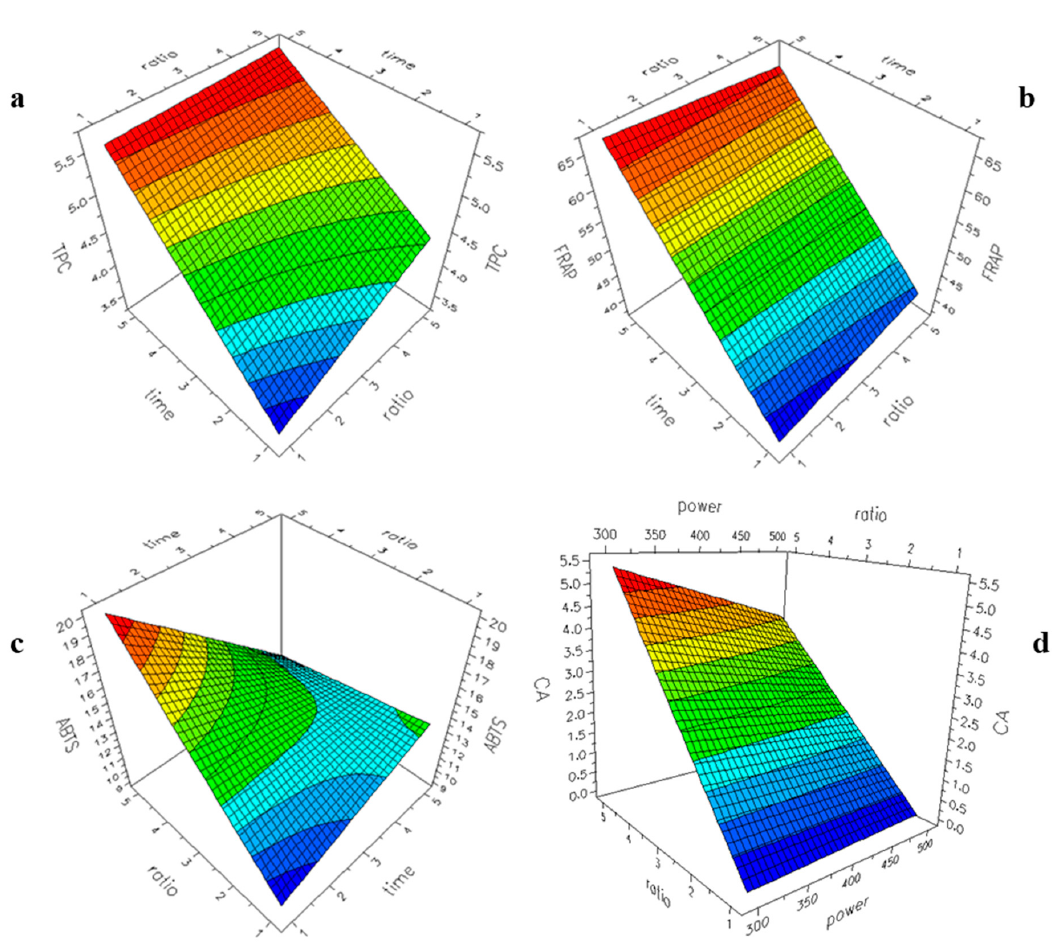
Figure 2. Surface plot showing the responses: ( a ) TPC (300 Watt), ( b ) FRAP (300 Watt), ( c ) ABTS (300 Watt), ( d ) CA (5 min). To make a comparison of the phenolic content and in vitro activities of the MAE extract with classic home preparations, infusions and decoctions were prepared and analyzed. Since two grams of L. barbarum leaves were used to prepare infusions and decoctions (150 mL), the prediction function of the software provided the values of TPC, FRAP, ABTS, and CA for a MAE extract from two grams of leaves in 150 mL, irradiated for 5 min at 300 W. Figure 3 shows the values of TPC, FRAP, ABTS, and CA content of L. barbarum leaf extracts obtained by MAE, decoction, and infusion. The results of post-hoc Tukey’s HSD test showed that the difference of the means was significant at the 0.05 level for all the analytical assays among MAE, decoction, and infusion treatments. Unexpectedly, lower values were obtained for the MAE extract compared to both infusion and decoction for all parameters studied; in particular, the CA content was strongly reduced when the MAE treatment was performed. Finally, L. barbarum leaf infusion had the highest values for the analytical assays, thus preserving bioactive compounds of the extract and its related properties.